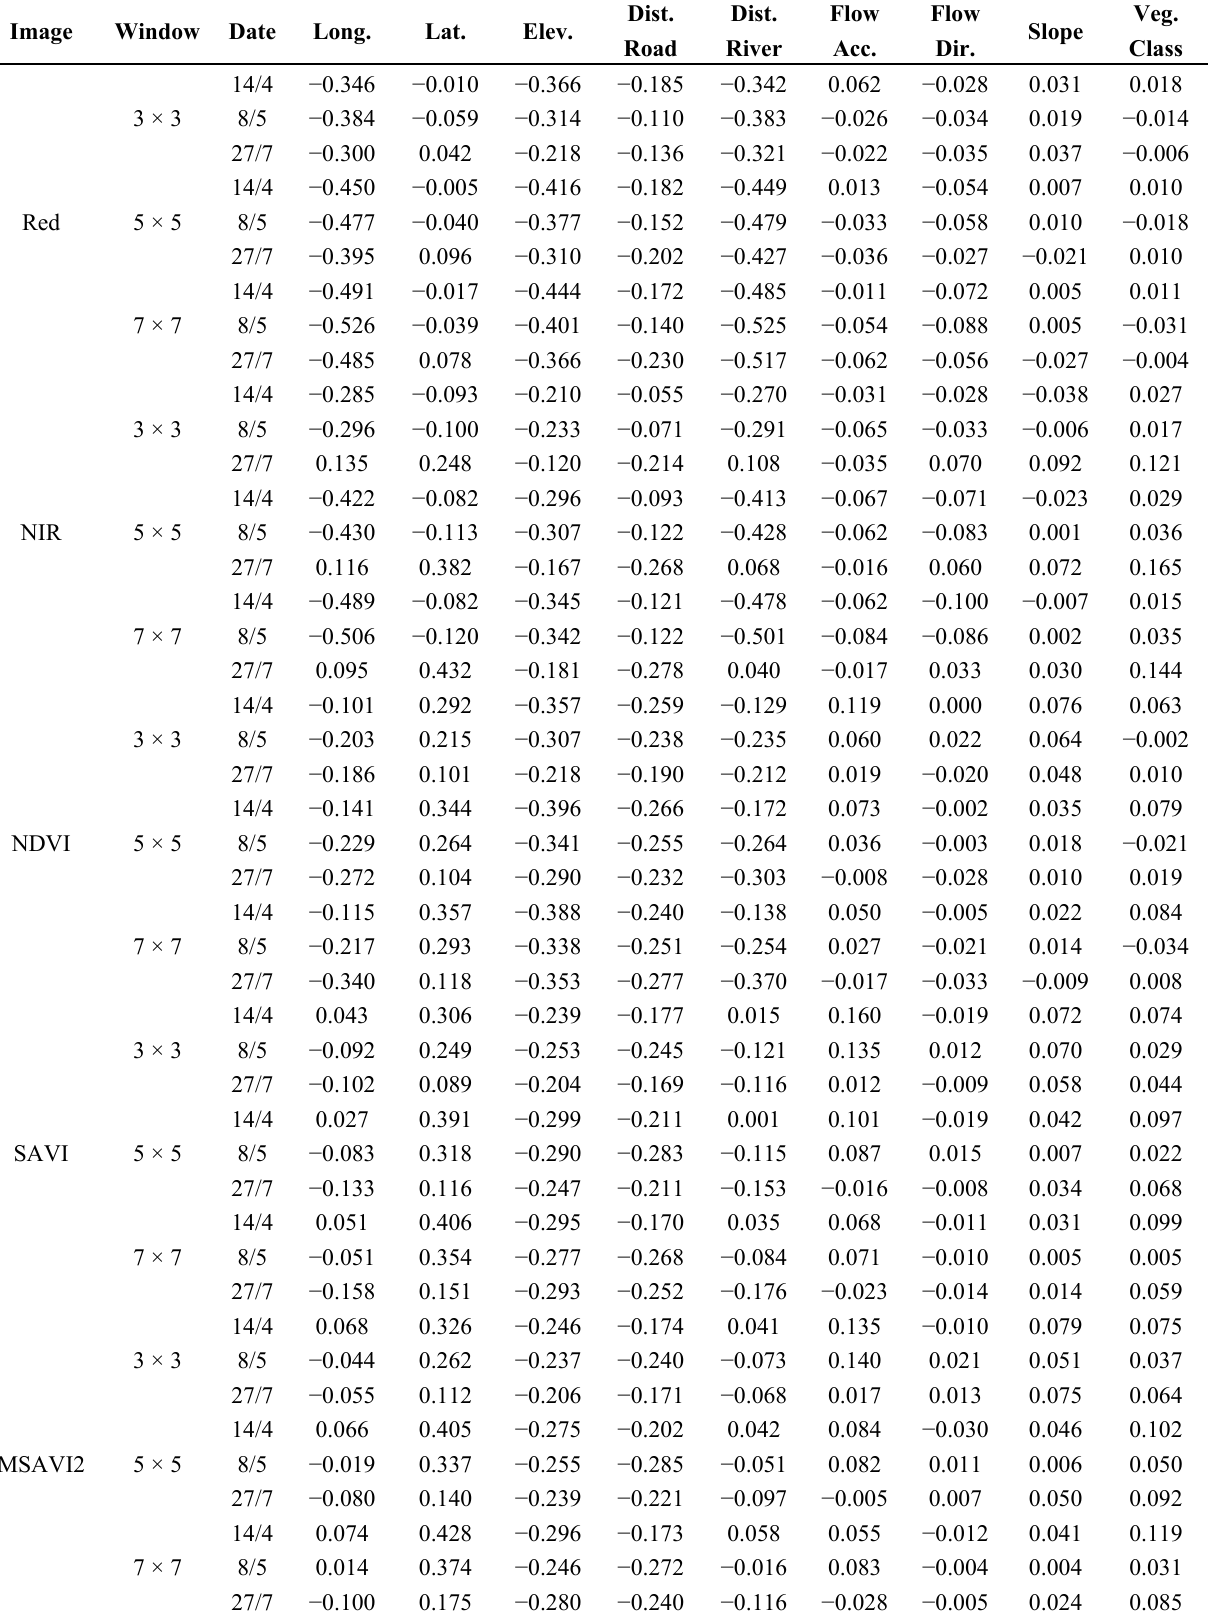
Table 4. Pearson’s correlation coefficients between environmental covariates and Moving Standard Deviation Index (MSDI) values in the southern comparison area of Chobe National Park, Botswana. All dates are in